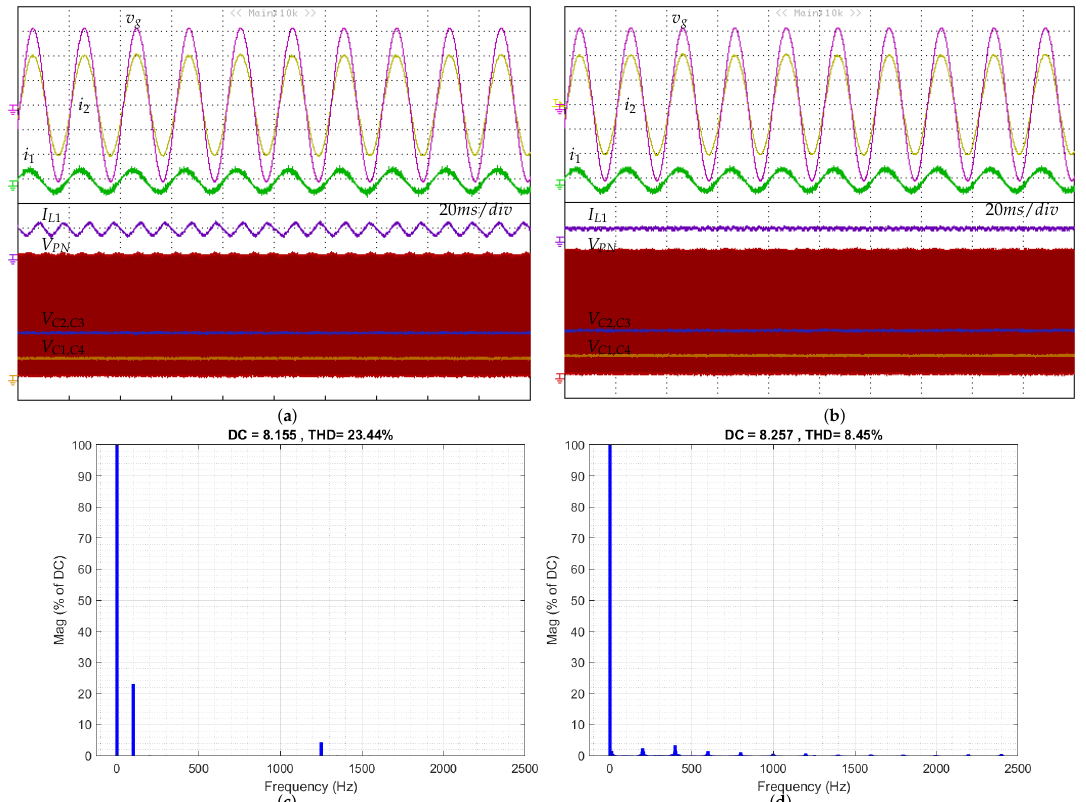
Figure 7. ( a ) Experimental steady-state results without double-line frequency reduction, ( b ) Experimental steady-state results with double-line frequency reduction, ( c ) Simulated spectrum of I L 1 in part ( a ), and ( d ) Simulated spectrum of I L 1 in part ( b ). ( i 1 = 20 A/div, i 2 = 5 A/div, v g = 100 V/div, I L 1 = 10 A/div, V C 1